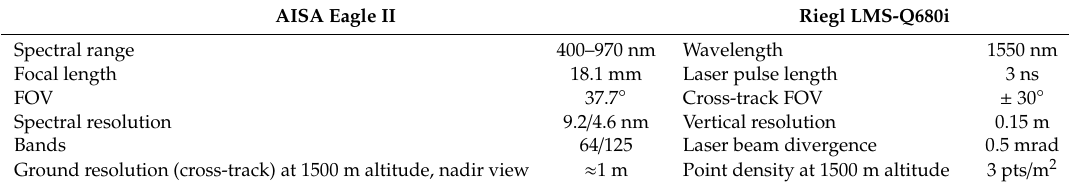
Table 1. Parameters of the hyperspectral and LiDAR sensor of the CAF-LiCHy system.